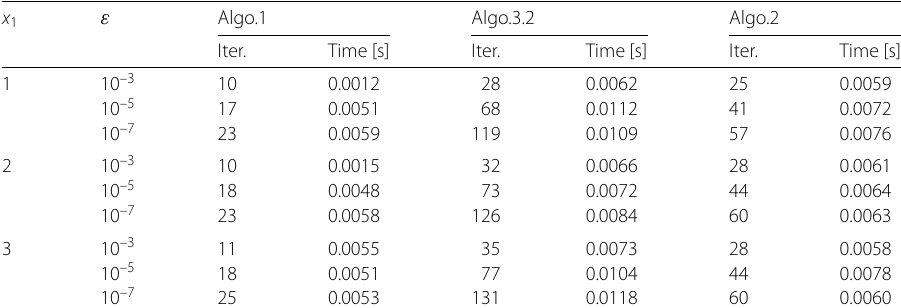
Table 2 Experiment with α n = 1